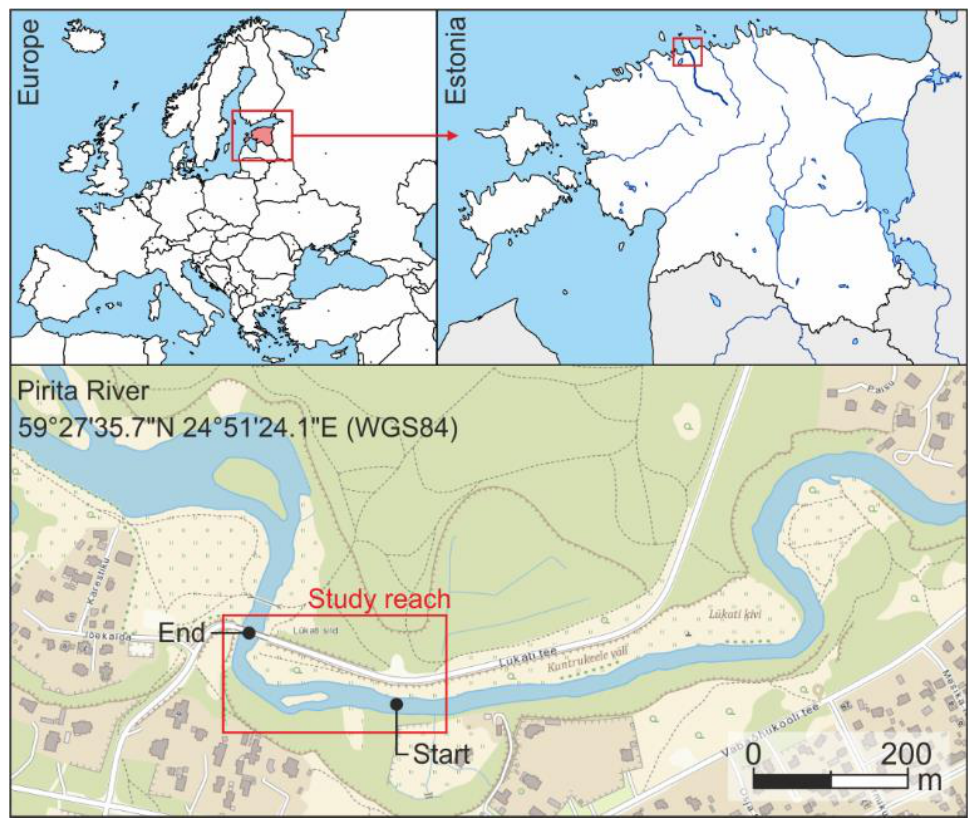
Figure 4. The situation of the study reach. Pirita River, Estonia.